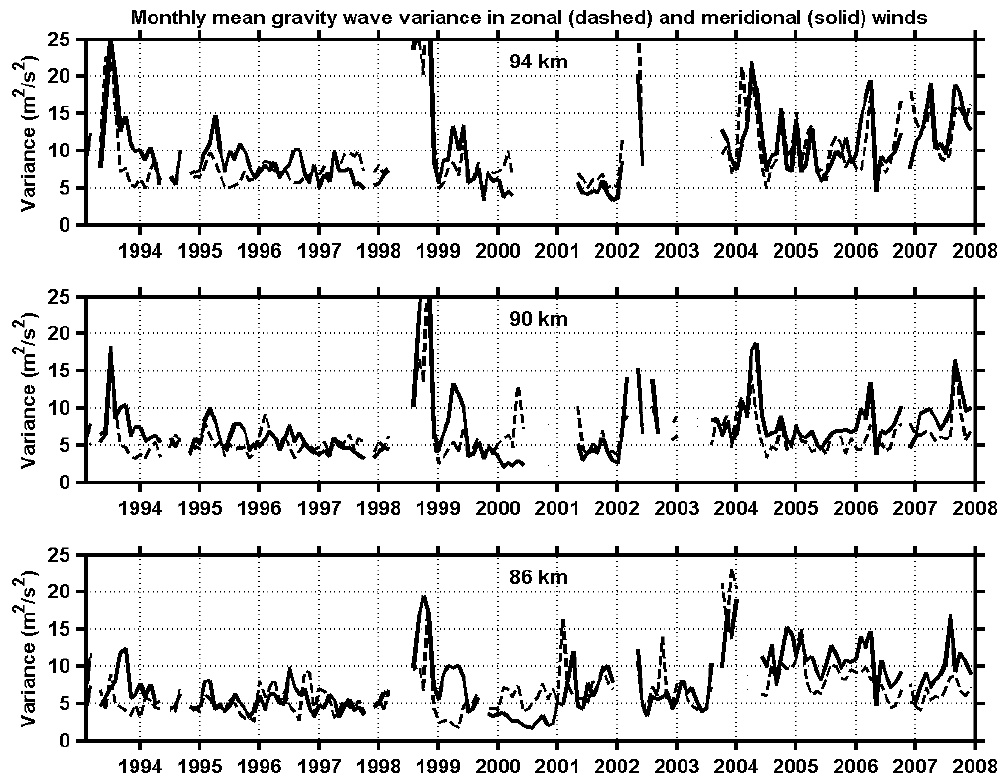
Fig. 2. Monthly mean gravity wave variances in zonal and meridional winds for the altitudes 86, 90 and 94km and for the period